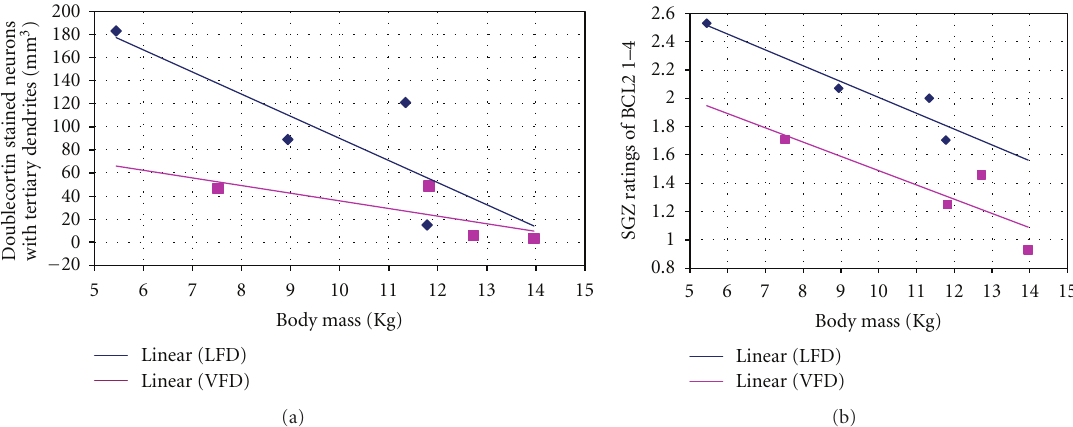
Figure 2: Correlation between in vivo adult body mass and postmortem measures of neurogenesis levels and BCL2 Expression. (a) shows a significant inverse correlation ( r = − 0 . 75, P = 0 . 03, n = 8) between body mass (in kilograms) and neurogenesis rates (indicated by the density of DCX-stained neurons with tertiary dendrites in per mm 3 in the SGZ). Regression line of both groups combined not shown. (b) shows a significant, inverse correlation ( r = − 0 . 73, P = 0 . 041, n = 8) between body mass (in kilograms) and BCL2 expression in the SGZ (determined by a 4-point rating scale). Regression line of both groups combined not shown. These results show that animals with higher body mass have reduced neurogenesis rates and BCL-2. DCX: doublecortin; BCL-2: B-cell leukemia lymphoma 2. VFD: variable foraging demand (adversely-reared); LFD: low foraging demand (normally reared).